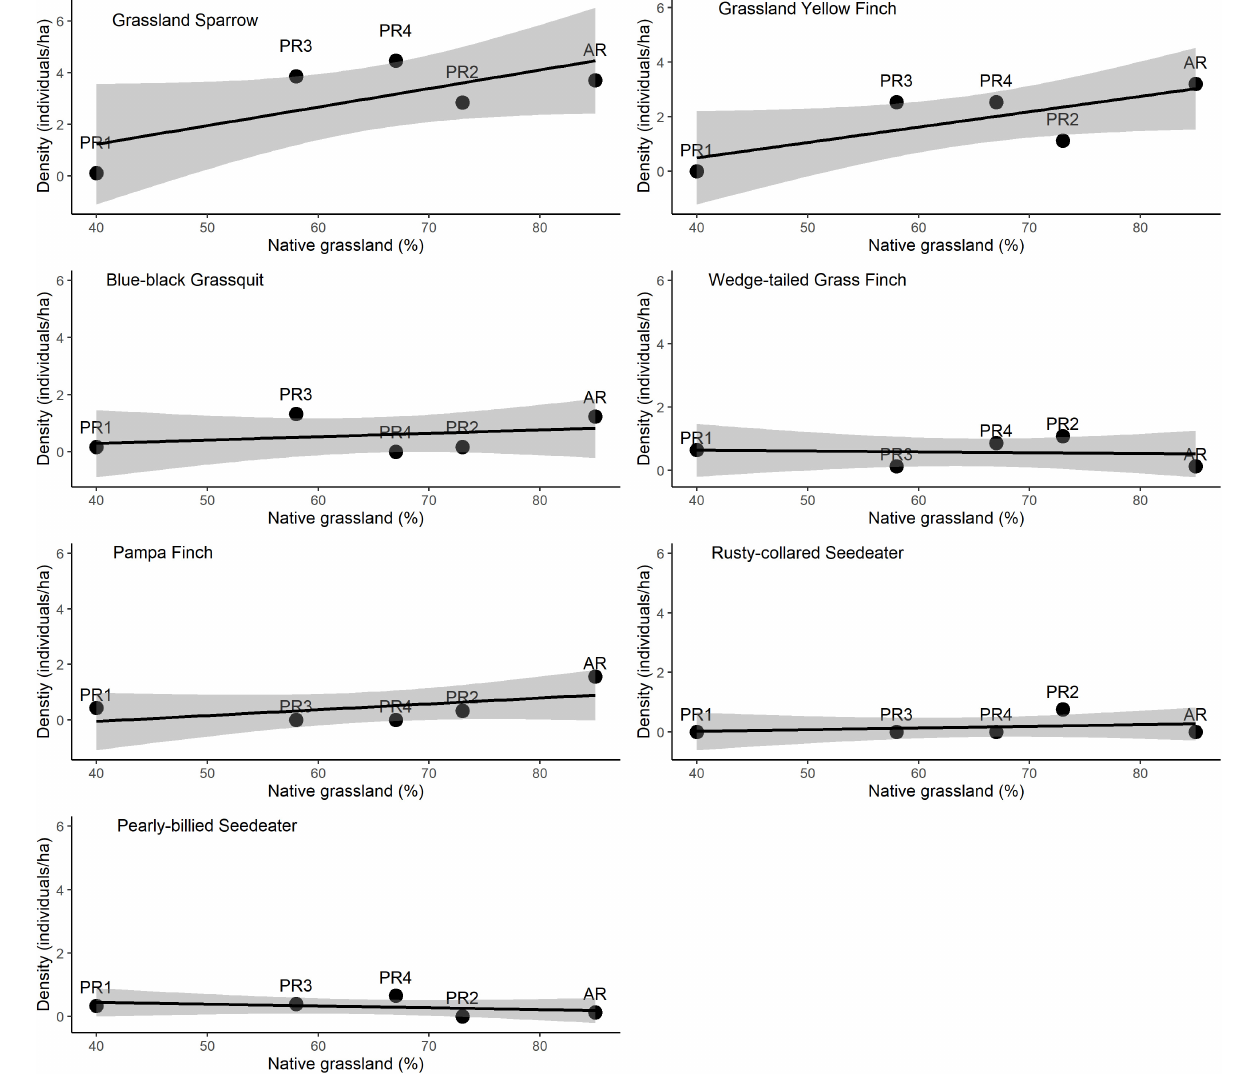
FIGURE 2 | Proportion of grassland-bird density (individuals/ha) per 6 to 12 point counts within each restoration site, to the amount of native grassland vegetation in the landscapes. Confidence intervals are in